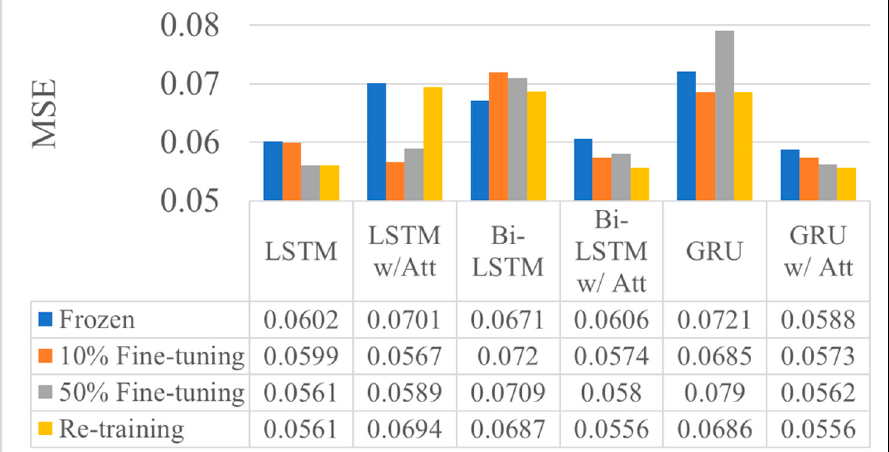
Figure 14. MSE of the target disease course prediction of TL-CDC with attention mechanism under k = 4.